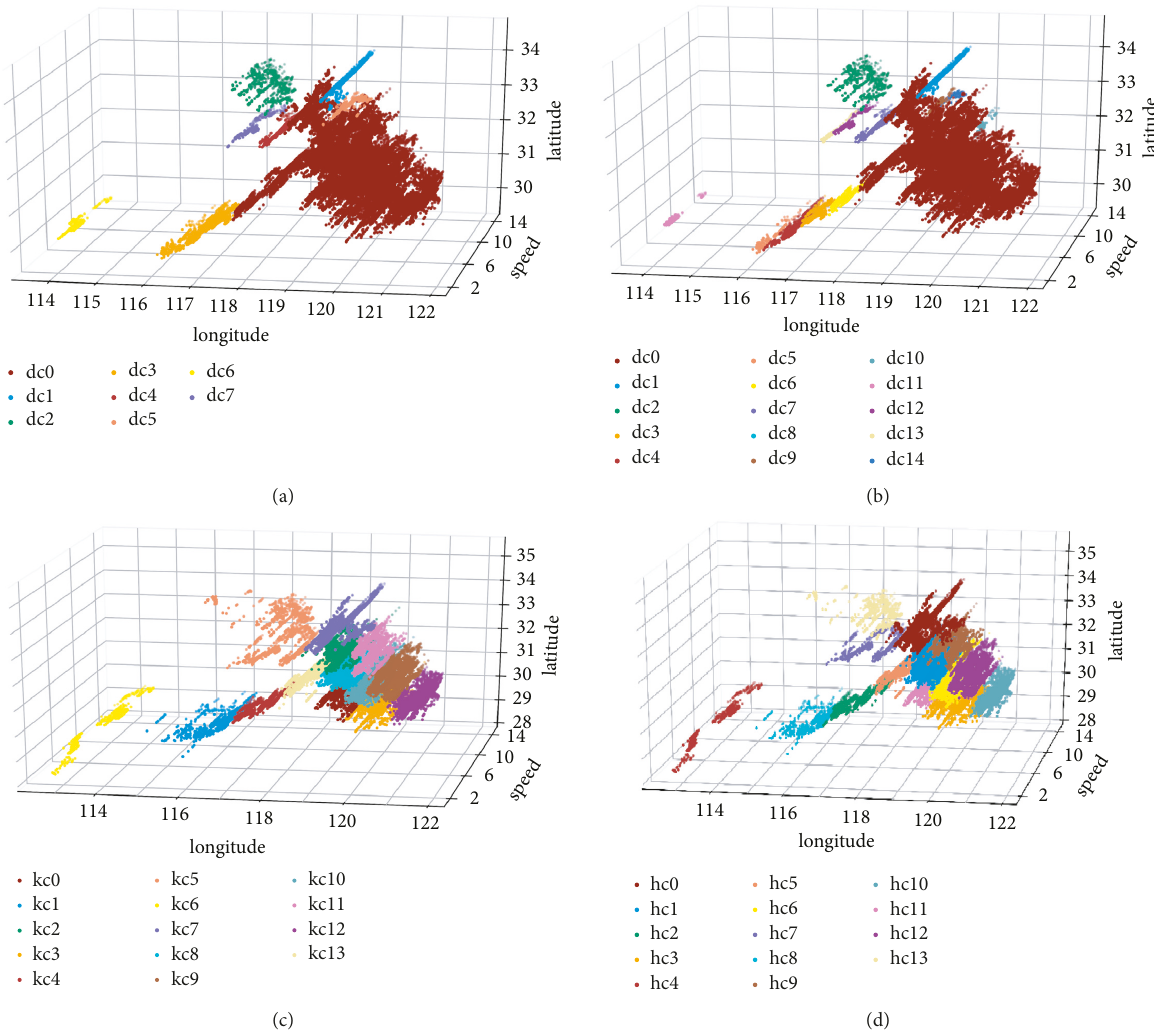
Figure 12: Clustering result visualization: (a) DBSCAN (eps � 0.003, MinPts � 150); (b) DBSCAN (eps � 0.002, MinPts � 100); (c) K-means (cluster number � 14); (d) HCA (cluster number �